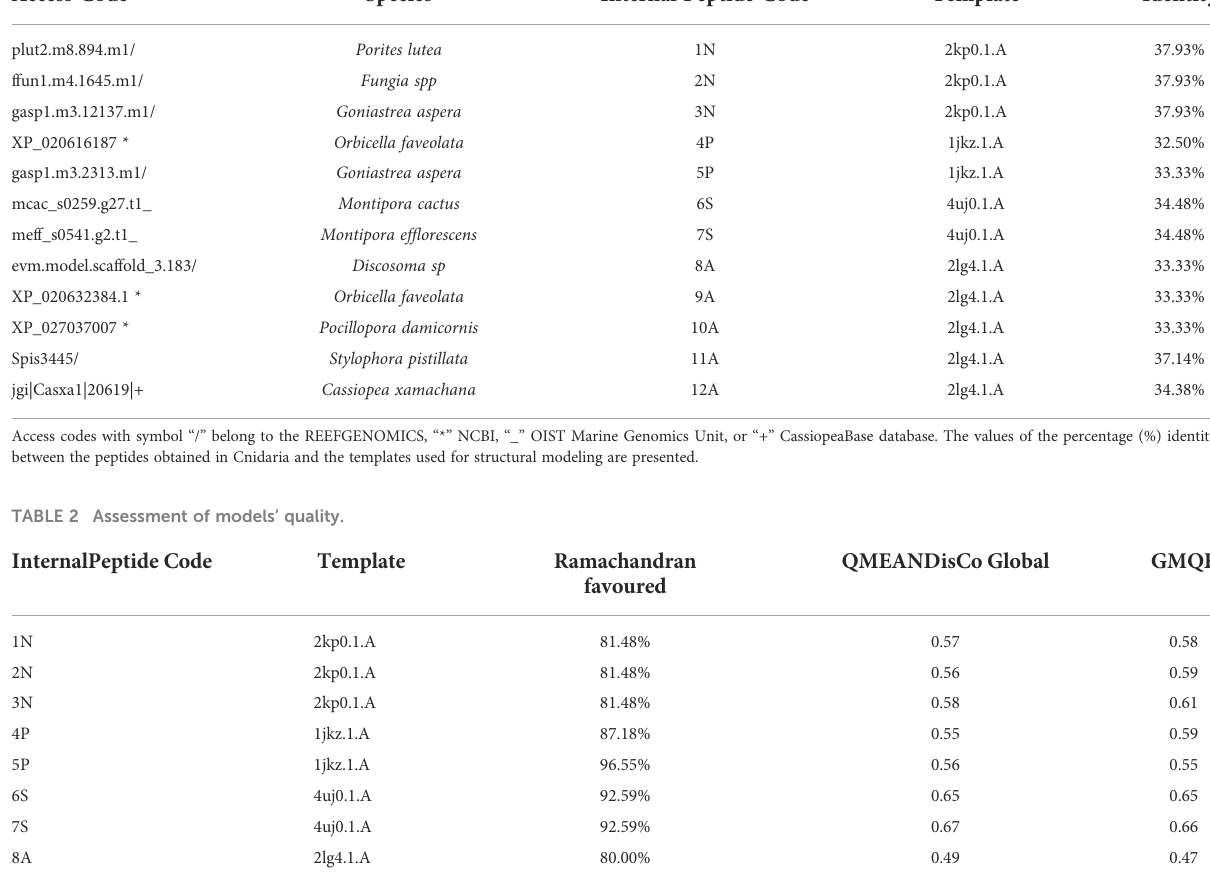
TABLE 1 Putative antimicrobial peptides from Cnidaria with minimum criteria to obtain a 3D structure. Access Code Species Internal Peptide Code Template Identity